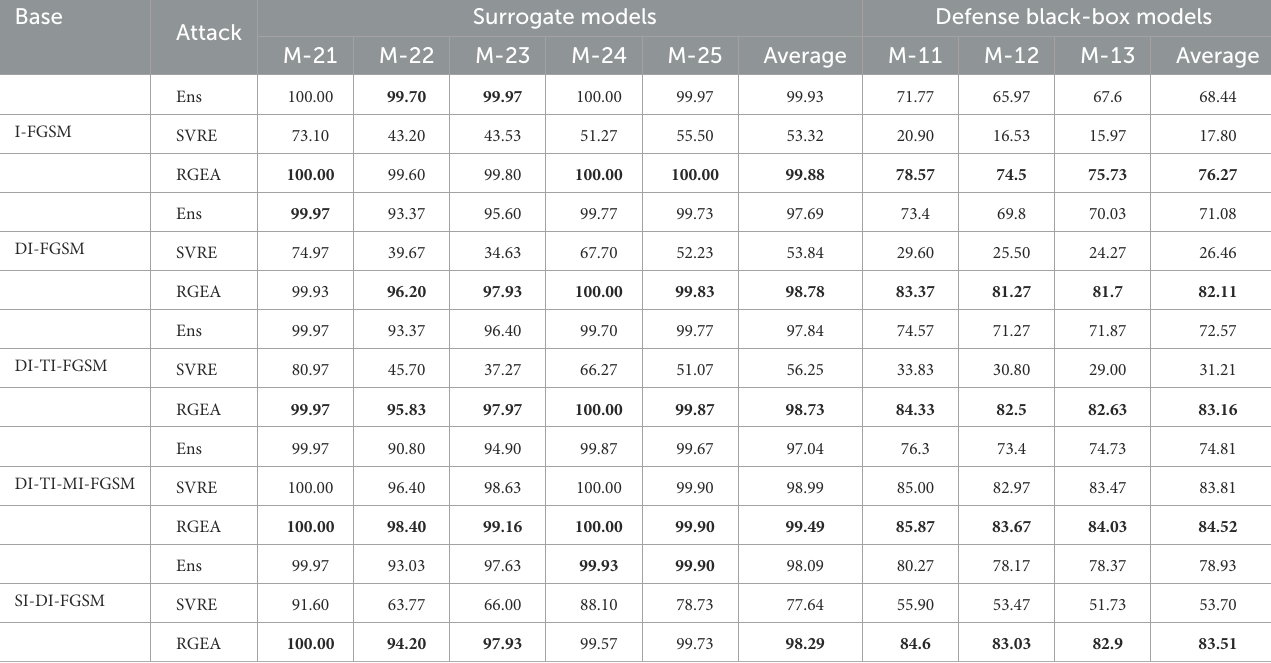
TABLE 3 The black-box attack success rates (%) against three models with the defense transform methods (BR, Xu et al., 2017; RP, Xie et al., 2018; and JPEG, Dziugaite et al., 2016). Base Surrogate models Defense black-box Attack